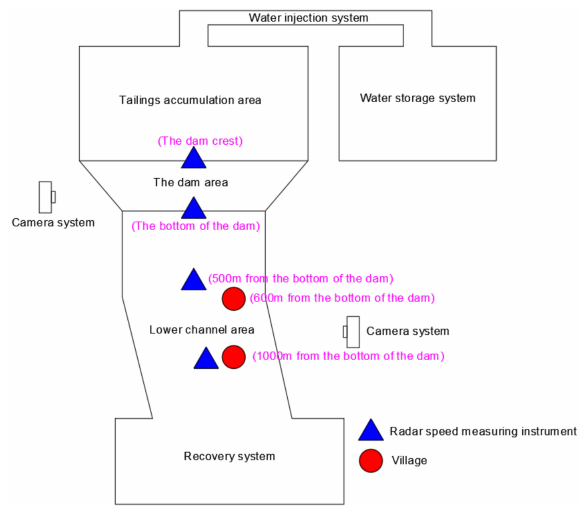
Figure 3. Schematic diagram of test